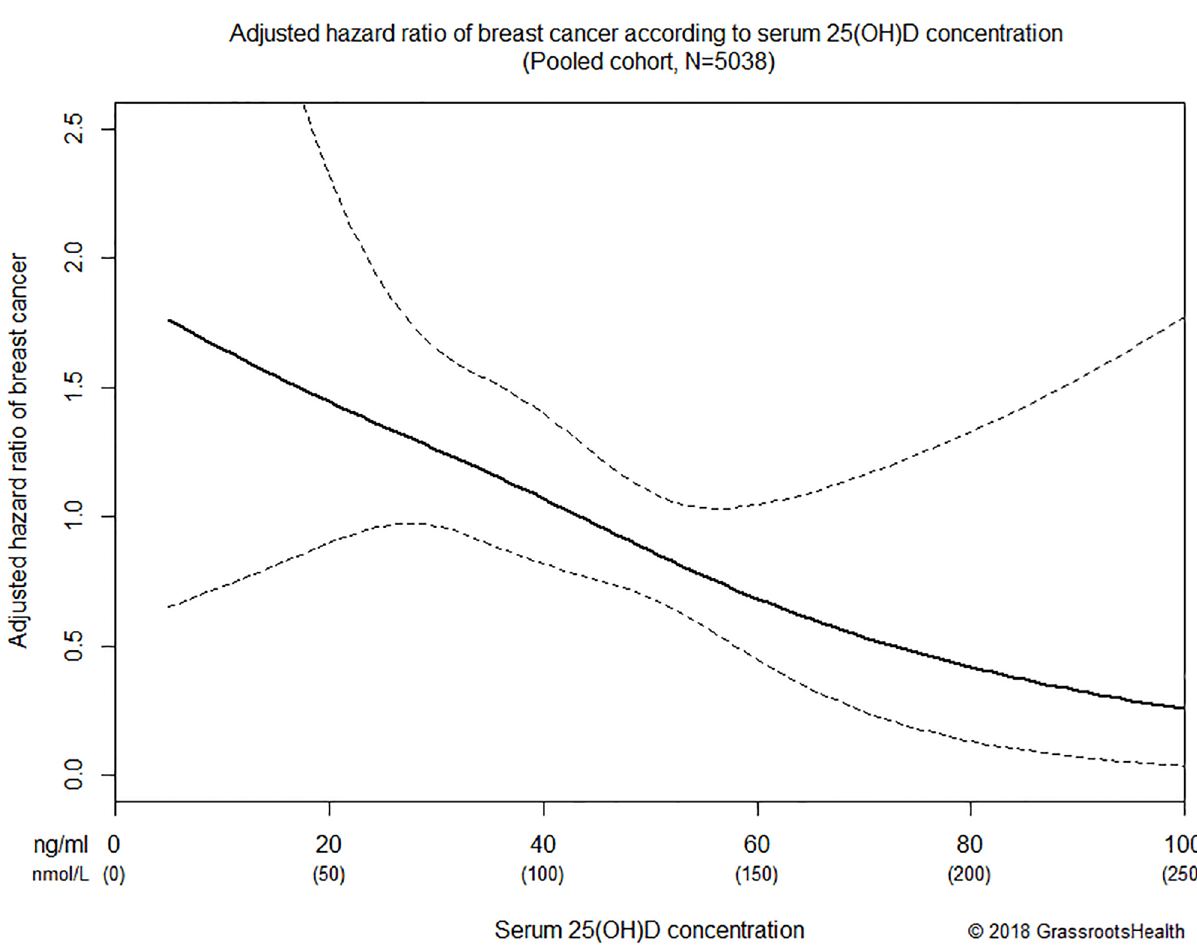
Fig 3. Association between serum 25(OH)D (as a continuous variable) and risk of breast cancer adjusted for age, BMI, smoking status, calcium supplement intake, and study of origin in the range of (cid:20) 100 ng/ml, pooled cohort (N = 5308). Solid black line represents the estimated hazard ratio for the Cox regression model with restricted cubic splines with three knots; dashed lines represent the 95% confidence interval of the estimate.